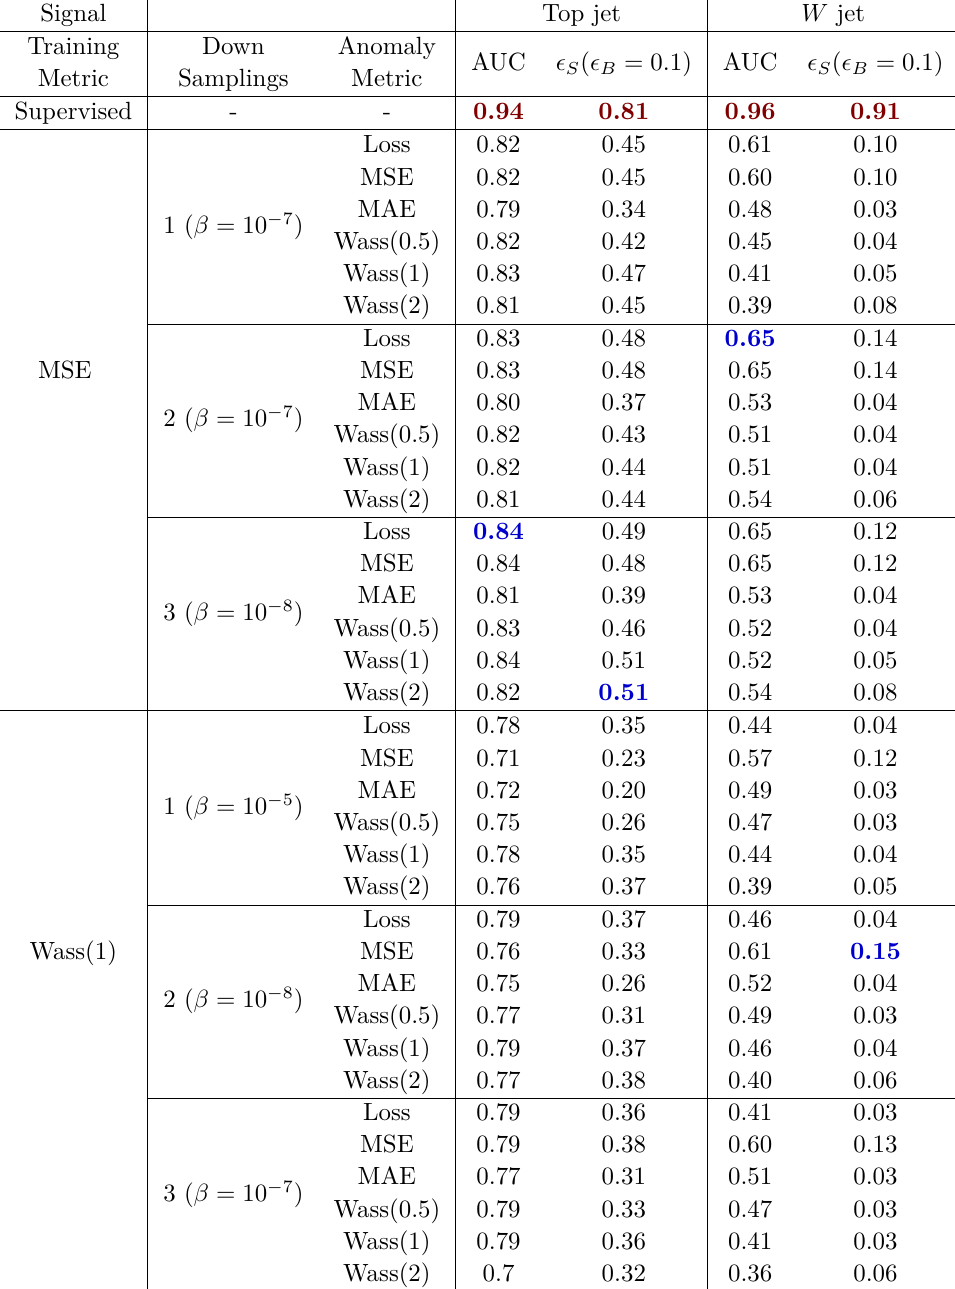
Table 1 . Results showing the ability of a VAE trained on QCD only samples to distinguish top and W jets from QCD jets. The Training Metric column shows which distance metric is used in the loss function for training, and the Anomaly Metric column shows the distance metric used at inference time. The bold blue entries mark the highest AUCs and signal efficiencies overall. We indicate the p -Wasserstein distance metric as Wass( p ), and the MPE with power α = 1 , 2 by MAE and MSE, respectively. The number in parenthesis in the Down Sampling column denotes the value of β which yields the lowest total loss on the validation set for the given number of down